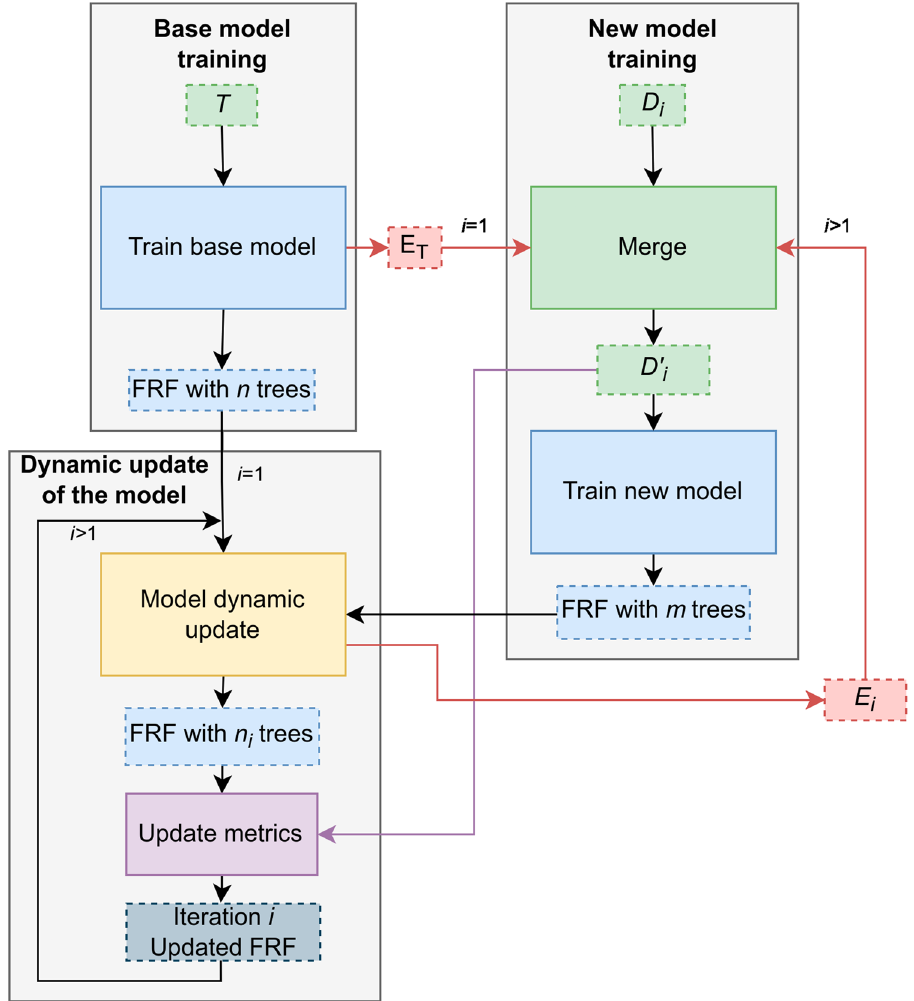
Fig. 1 Architecture of the itera- tive learning of Fuzzy Random